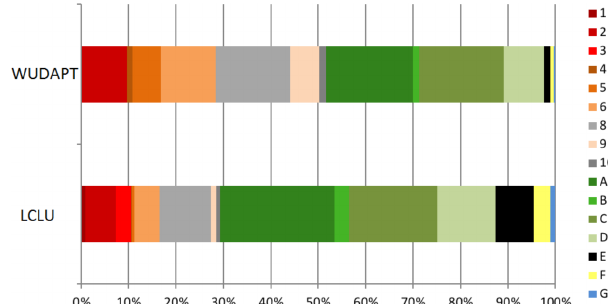
Figure 3. Percentage of the area covered by each LCZ using WU- DAPT and LCLU inside